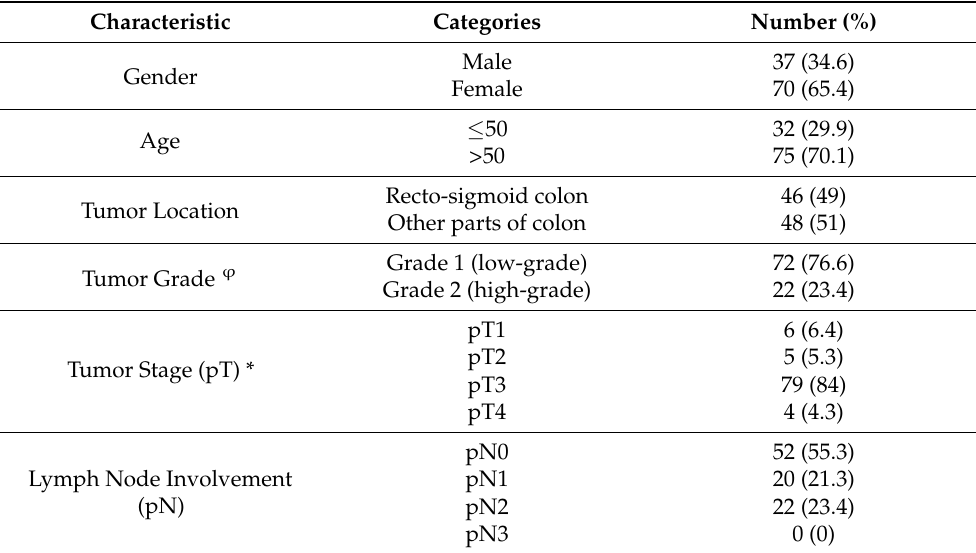
Table 1. Clinicopathological characteristics of the cohort of patients with colorectal cancer.